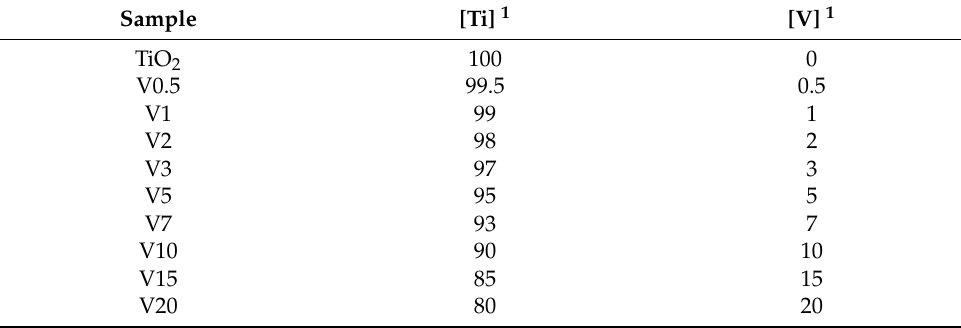
Table 3. Synthetized V-TiO 2